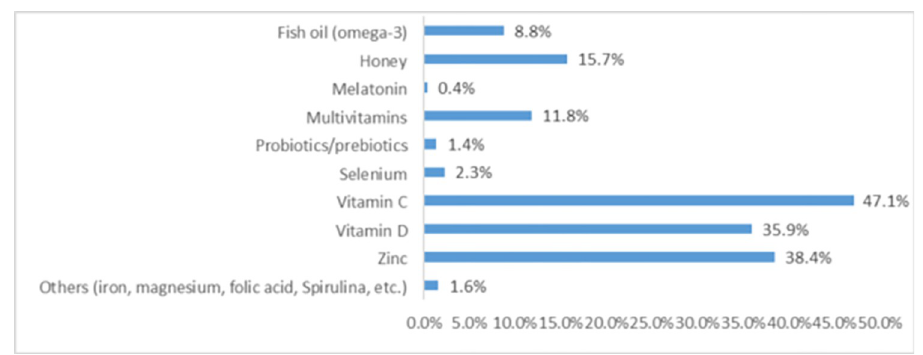
Fig 1. Types of vitamins and nutrients used for COVID 19 prophylaxis (N = 271).